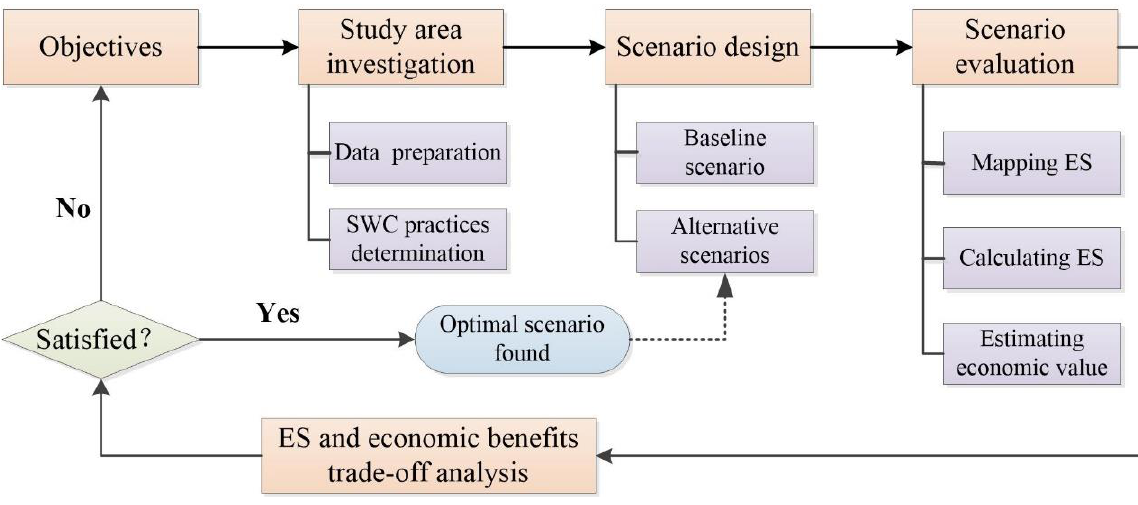
Figure 4. A framework of scenario analysis process for ES assessment of SWC